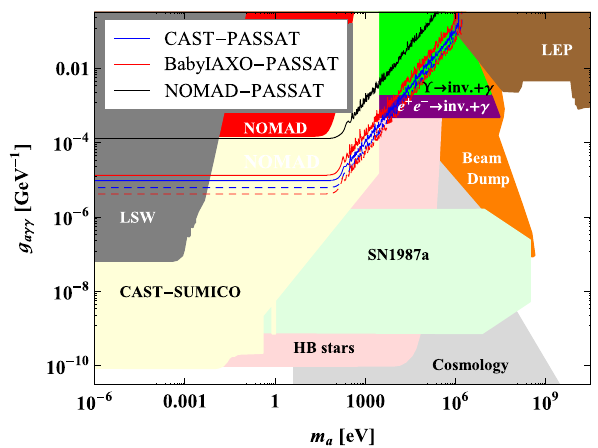
Fig. 3 Expected experimental sensitivity that can be achieved by PAS- SAT with CAST (blue lines) and BabyIAXO (red lines) magnets, in the plane of ALP mass m a and the associated photon coupling g a γγ . The NOMAD ALP search in [24] is reinterpreted in terms of PASSAT as the experiment possesses the main features of PASSAT, and the black solid line shows the resulting limit. Dashed lines are the correspond- ing sensitivities with prospective B of 20 T for CAST–PASSAT and BabyIAXO–PASSAT. The current bounds summarized in e.g., Refs. [18,35] are from existing ALP searches. The prospective limits are estimated by 90% C.L. under the assumptions of 10 (negligible) back- ground events for BabyIAXO-PASSAT (CAST-PASSAT) and 2 × 10 20 POT. The NOMAD case is calculated with the expected number of background events reported in [24], being normalized to 1 . 08 × 10